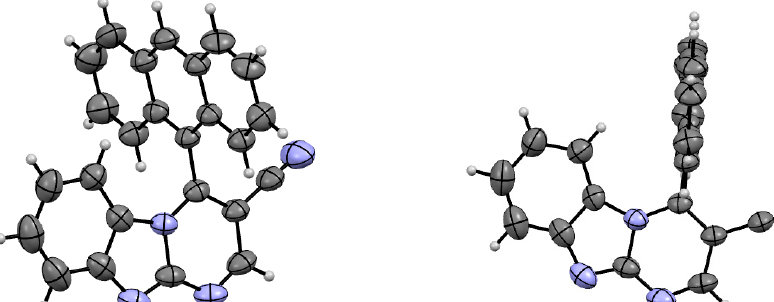
Figure 1. Molecular structure of 6c.